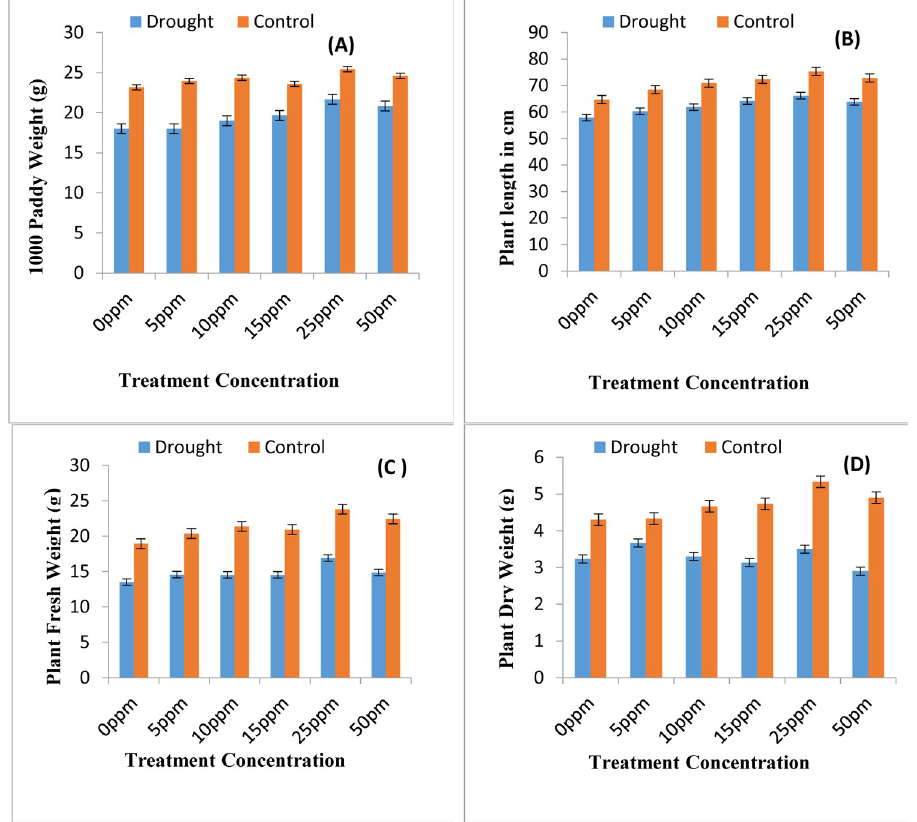
Fig 4. Yield and growth attributes of rice plants. (A) 1000 paddy weight (B) height of plants (C) Plant fresh weight and (D) plant dry weight as affected by various regimes of ZnONPs under water scarce and well irrigated environment (mean ± SE; n =